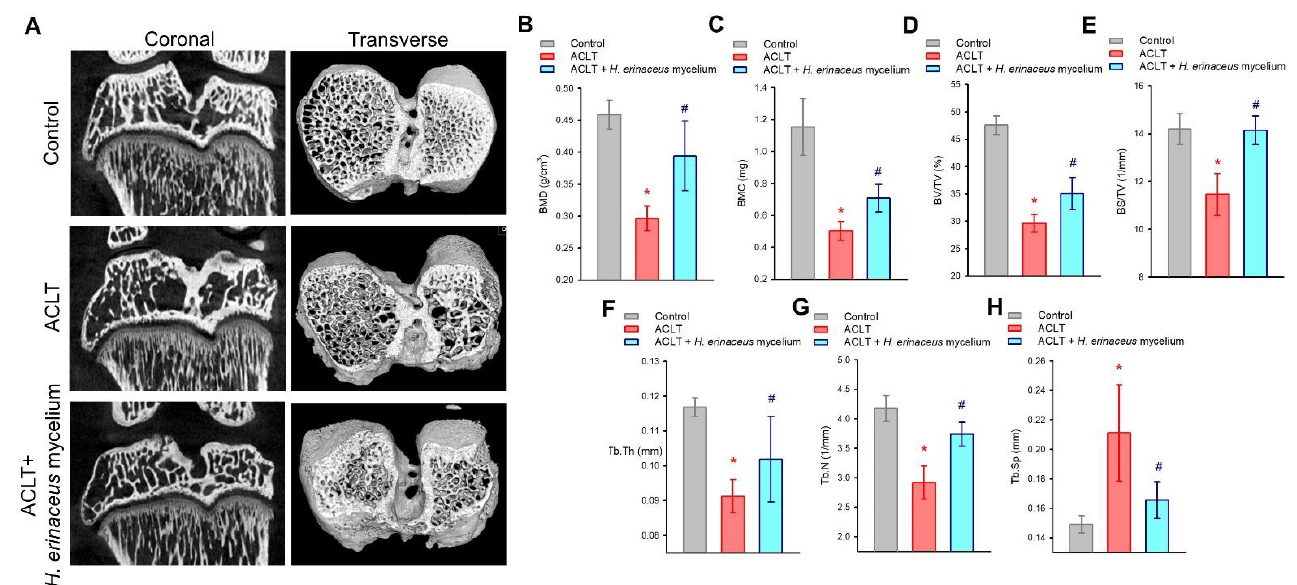
Figure 3. Micro-CT analysis of the effects of H. erinaceus mycelium on the ACLT bone architecture. ( A ) Representative micro-CT images from knee subchondral bone. Quantitative analyses of ( B ) BMD, ( C ) BMC, ( D ) BV/TV, ( E ) BS/TV, ( F ) Tb.Th, ( G ) Tb.N and ( H ) Tb.Sp ( n = for each group). * p < 0.05 compared to the control group; # p < 0.05 compared to the ACLT-only group.